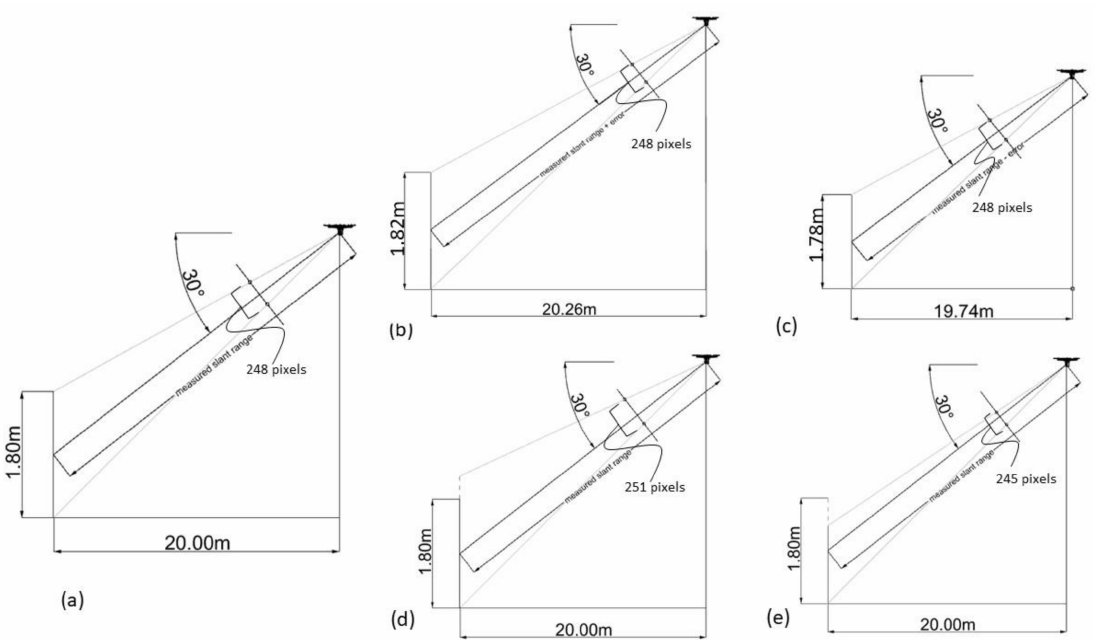
Figure 8. Case scenario developed in the 3D CAD Rhinoceros where a DJI Phantom 4 PRO is looking at a target of 1.80 m from a horizontal distance of 20 m. Slant distance is measured through a laser range finder ( a ). The error associated with the measured slant range (assumed to be ± 0.30 m as an example) generates uncertainty in the horizontal distance, which lays between 20.26 m and 19.74 m. Keeping constant the other parameters (pitch angle equal to 30 ◦ and total pixels equal to 248), the horizontal uncertainty generates uncertainty in the calculation of height, which lays between 1.82 m ( b ) and 1.78 m ( c ). The camera ray line is not collimating to the top or bottom of the target: in other words, the erroneous value of the distance from the image center measured in pixels that may generate an error in the estimation of the height of the target. A 3-pixel di ff erence may generate an error of ± 0.021 m (( d ) and ( e ), the error is exaggerated to underline the issue) (source: personal